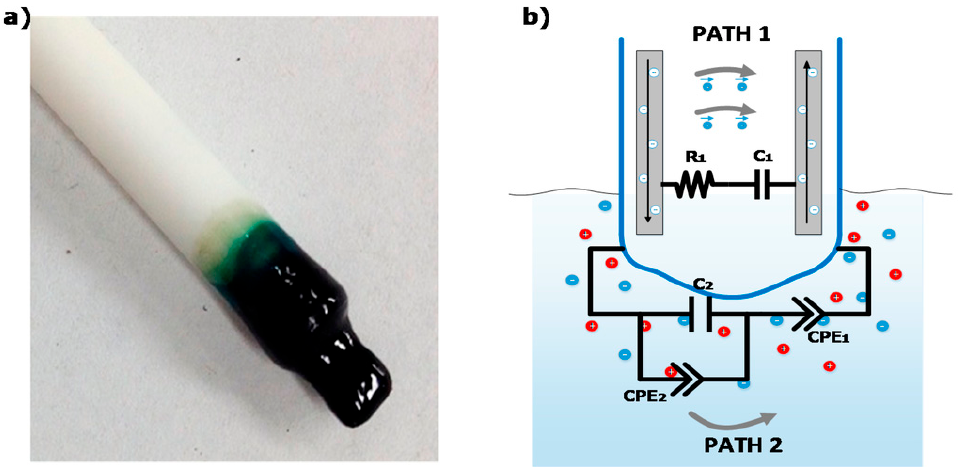
Figure 1. ( a ) Picture of the polyvinyl chloride-bis(2-ethylhexyl) phthalate (PVC-BEHP) electro-chemical nitrate sensor; ( b ) schematics of the main electrical conduction paths, one within the polymer membrane and the other into the medium under test (taken from Ghaffari et al. 2015) [23]. The polymer membrane is composed of high molecular weight polyvinyl chloride (PVC, from Aldrich, St. Louis, MO, USA) and of a plasticizer bis(2-ethylhexyl) phthalate (BEHP, from Aldrich). Ion-selectivity is provided by adding two components to the polymer membrane: an ionophore and an ionic site. For the nitrate sensor, the ionophore consisted of tetramethyl cyclotetra-decanato-nickel(II) complex (NiTMTAA), and the ionic site consisted of trioctylmethylammonium chloride (TOMAC, from Aldrich). Both of these have been chosen according to the reversibility, selectivity (>4 (cid:1868)(cid:1837) where A − stands for NO 2 − , HPO 42 − , SO 42 − , or Cl − ) and efficiency reported in previous potentiometric studies [24,25]. All chemicals, except the synthetized ionophore, were reagent grade and used without further purification. The sensors were fabricated using a dip-coating process to cover the electrodes uniformly with the polymer membrane. The electrodes were made from copper wires (923UL-9 from Consolidated Electronic Wire and Cable, Franklin Park, IL, USA), and inserted in a 5-mm-diameter, 100-mm-long alumina rod comprising two parallel hollow cavities spaced by a gap of 0.6 mm. Alumina has been chosen for its dielectric, mechanical, and chemical strength properties. The copper wires protruded out of the alumina rod of a length of 5 mm along which the polymer membranes were coated. The dip-coating process consisted of immersing the protruding copper wires into a THF-dissolved polymer solution of abovementioned composition, followed by 24-h drying at room temperature in order to let the THF evaporate and the polymer membrane solidify. Successive dipping and drying were performed until all the electrodes were fully covered by a 1-mm-thick membrane.